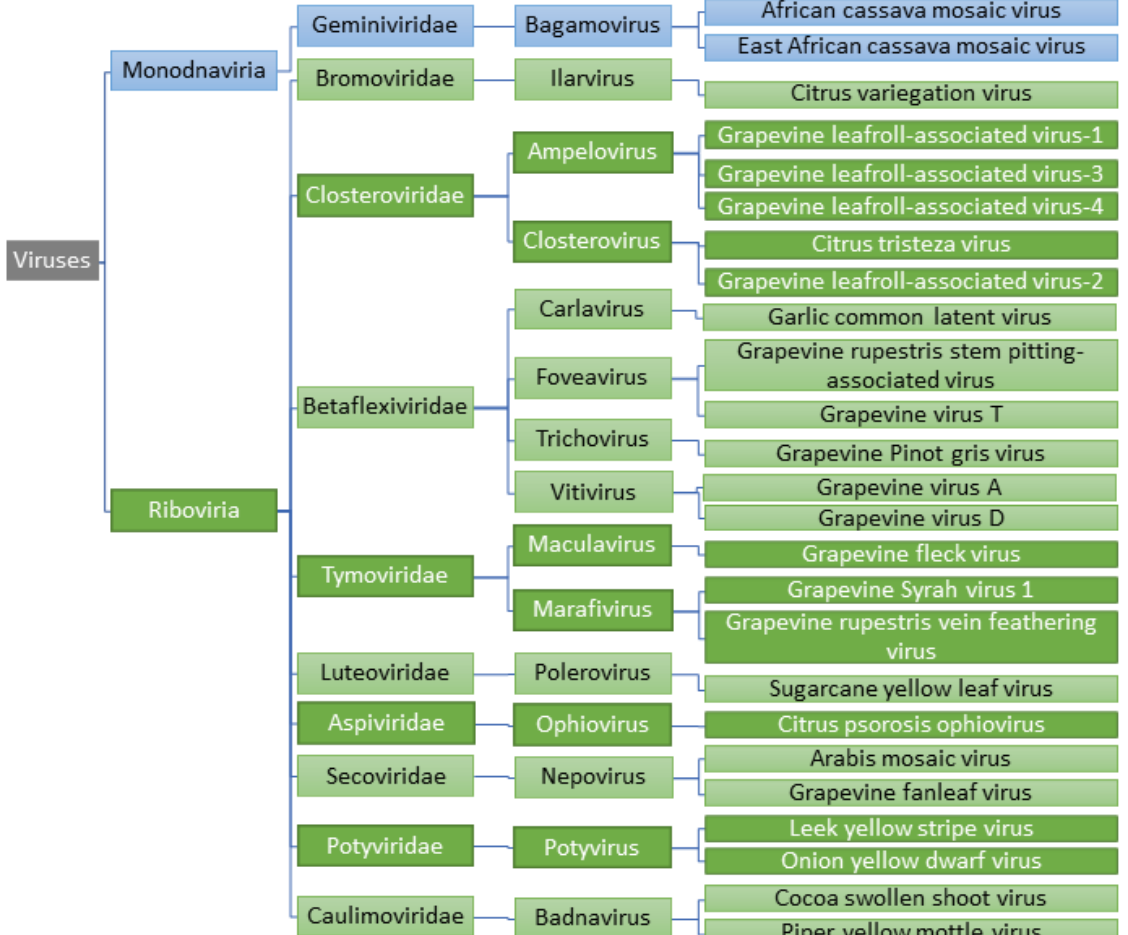
Figure 1. ICTV taxonomy of viruses involved in SE experiments.